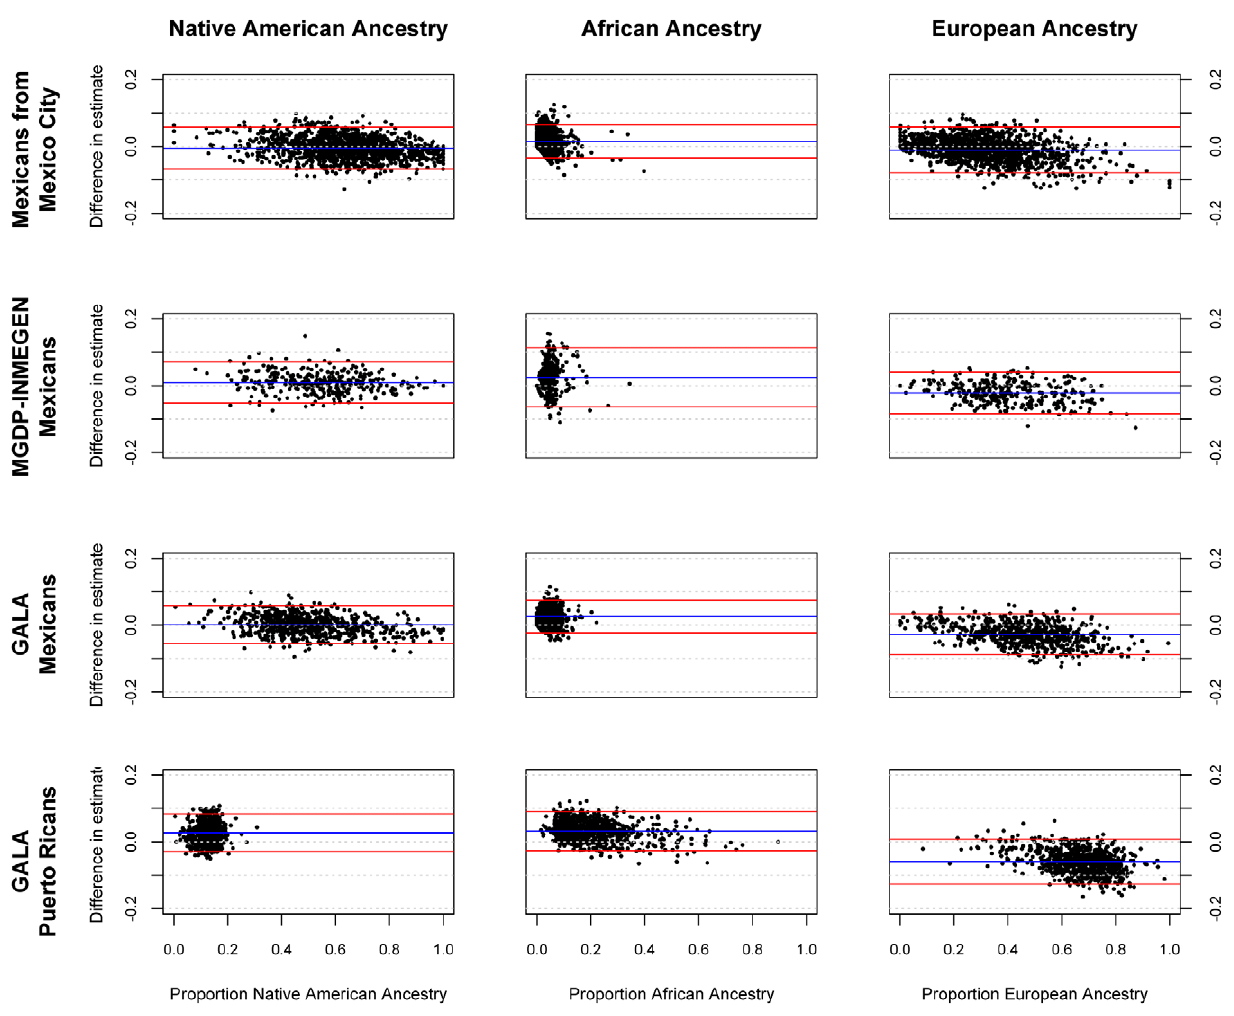
Figure 1. Bland-Altman plots showing error in individual ancestral estimates using AIMs to ancestral estimates using GWAS data. The x-axis shows the ancestry estimate using GWAS data; the y-axis shows the difference in estimates between GWAS and AIMs data using the 425 AIMs genotyped in the GALA Mexicans and Puerto Rican samples, 314 AIMs for the Mexico City sample, and 398 AIMs for the MGDP-INMEGEN sample.